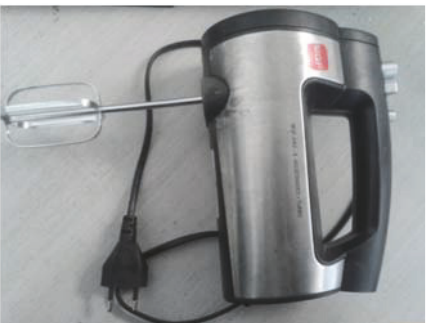
Figure 12: The agitator.